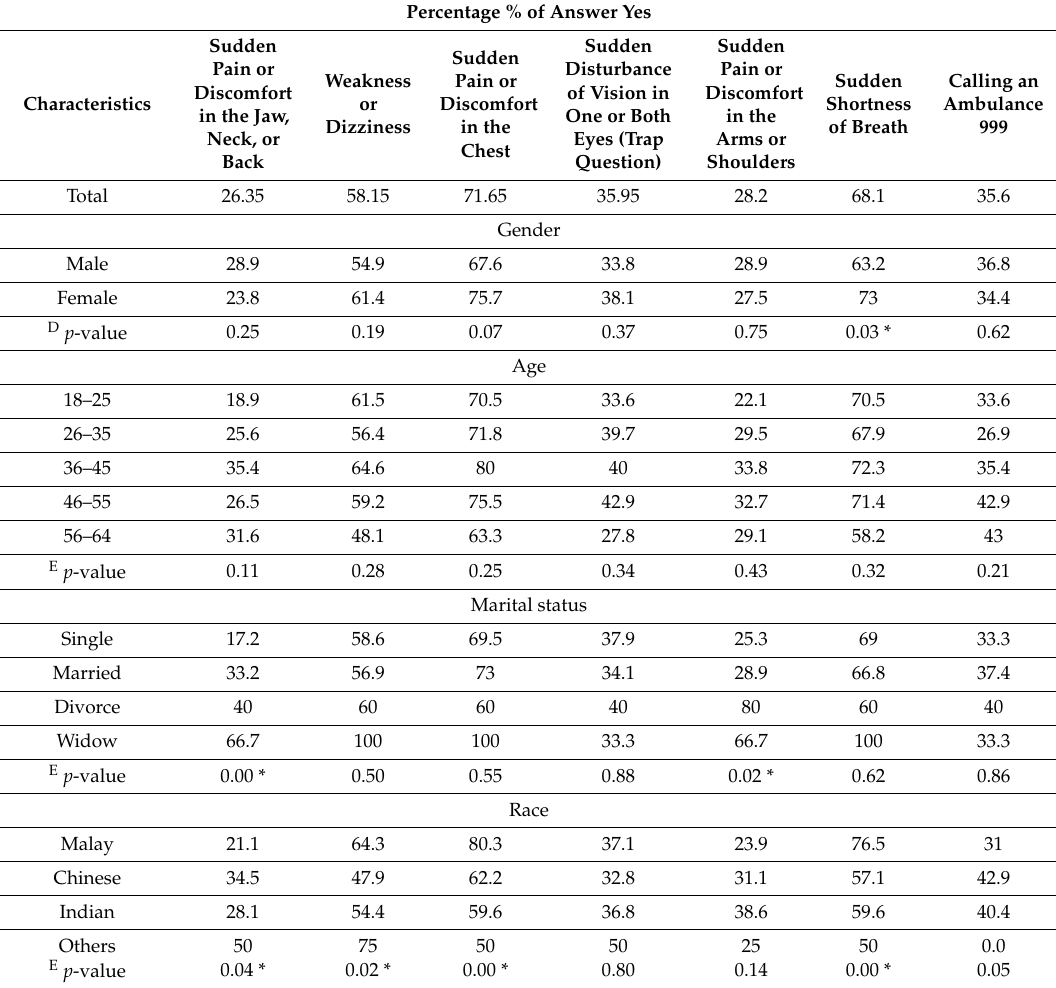
Table 2. Awareness of each symptom of heart attack and calling an ambulance.